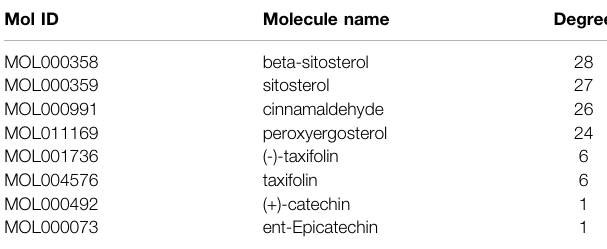
TABLE 3 | Degree value of eight main active components of Guizhi.